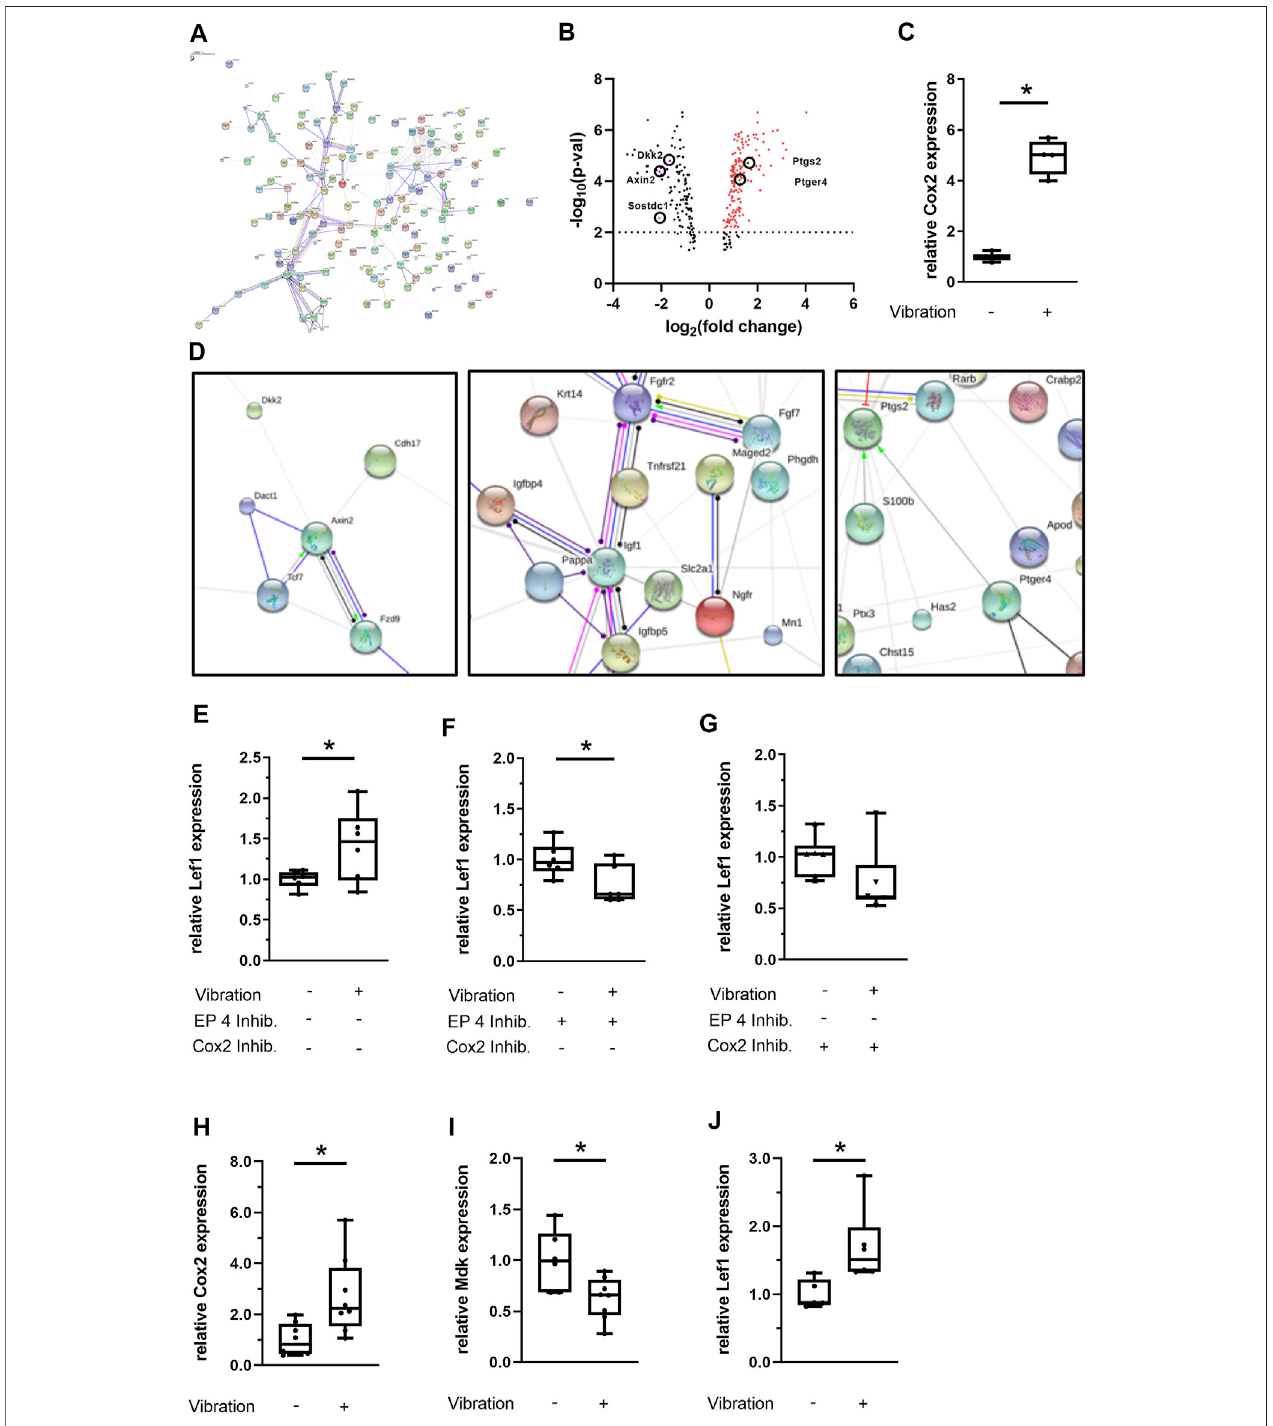
FIGURE 6 | Transcriptome analysis of MC3T3-E1 cells and gene expression analysis of hMSCs upon vibration treatment under estrogen-free conditions. (A) Nondetailed STRING protein-association network (action) derived from the MC3T3-E1 microarray data. The image in high quality can be found in the supplemental material ( Supplementary Figure S4 ). (B) Vulcano plot of differentially regulated genes and (C) qPCR validation of Cox2 expression in MC3T3-E1 cells. (D) Detailed STRING network (MC3T3-E1 microarray). (E – G) Effect of LMHFV in MC3T3-E1 cells pretreated with the EP4 antagonist AH23848 (1 × 10 − 6 M) or with the Cox2 antagonist celecoxib (1 × 10 − 6 M). (H – J) Effect of LMHFV in hMSCs. Data are shown as box-and-whisker plots (with median and interquartile range) from max. to min., showing all data points. N (cid:1) 4 – 6 per group (vibrated and sham-vibrated), *indicates signi fi cant effects with p ≤ 0.05.